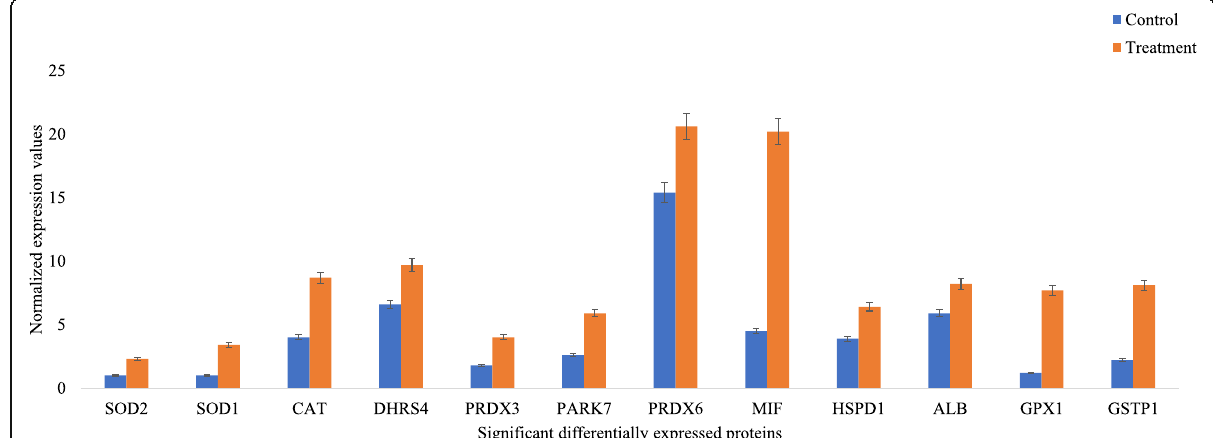
Fig. 4 The significantly differentially expressed proteins commonly found in both groups but which were more abundant in the treatment group compared with the control. SOD1 superoxide dismutase 1, SOD2 superoxide dismutase 2, CAT catalase, DHRS4 dehydrogenase/reductase SDR family member 4 (fragment), PRDX3 thioredoxin domain-containing protein, PARK7 DJ-1_PfpI domain-containing protein, PRDX6 peroxiredoxin